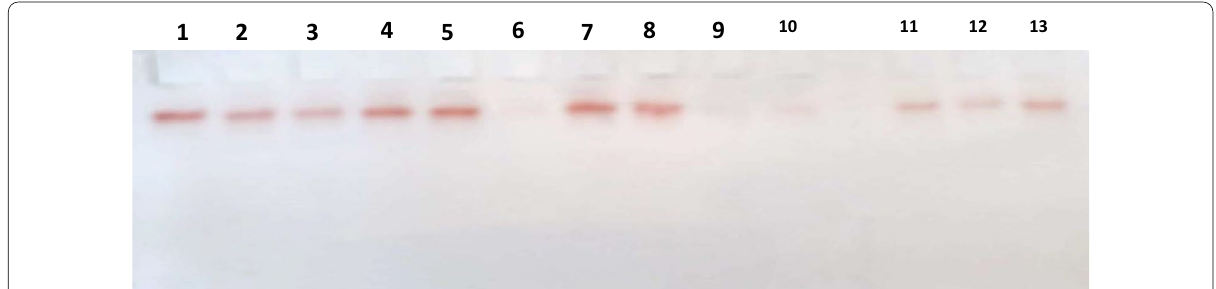
eight parents and lane 9: =